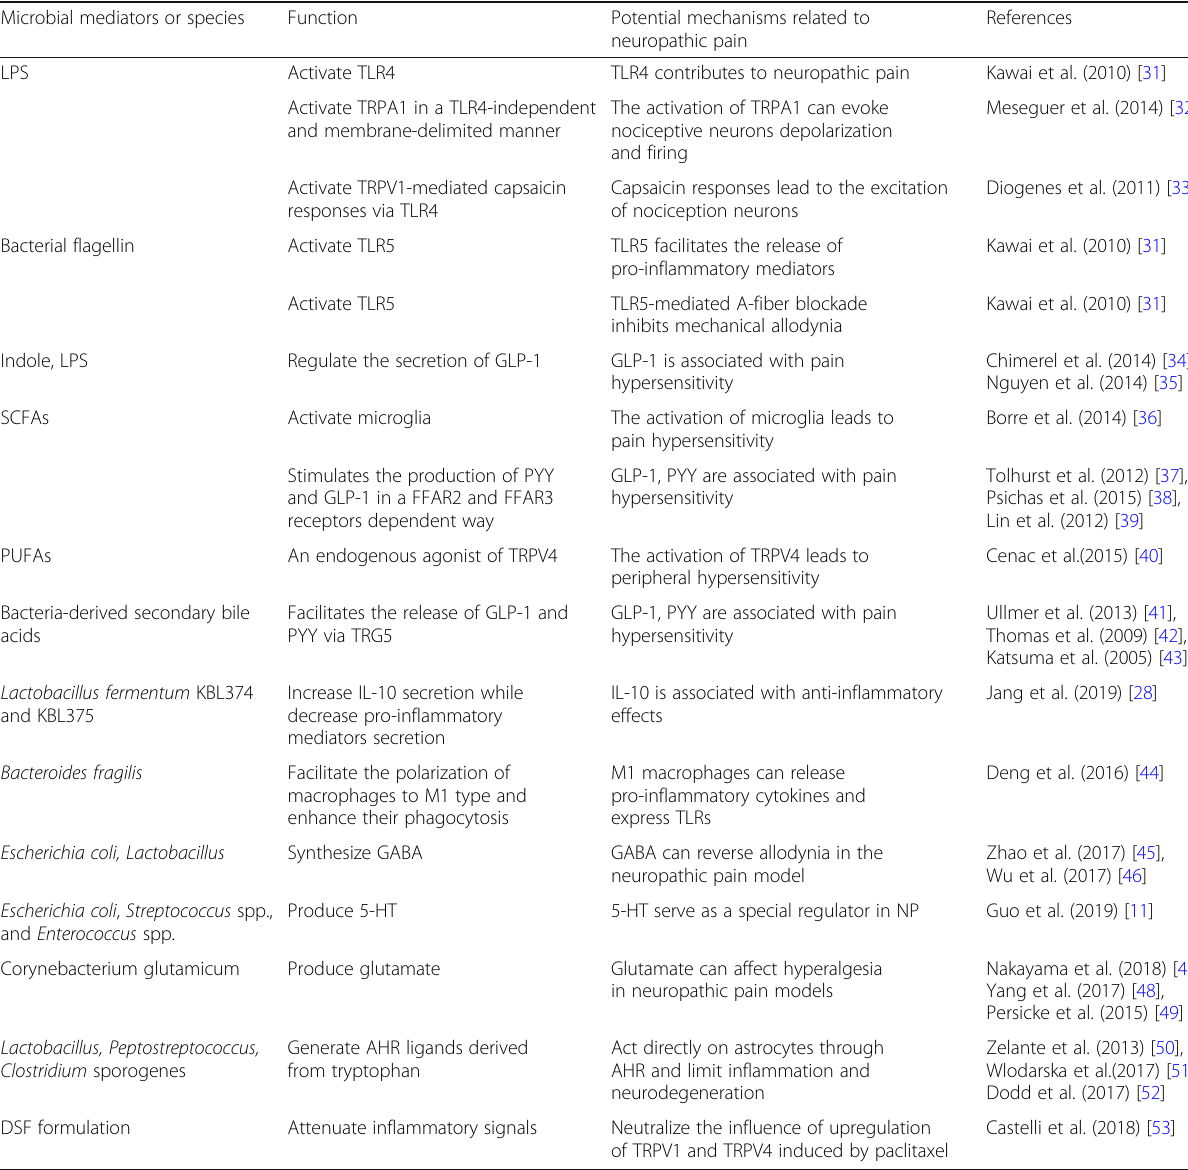
Table 1 Microbial mediators/species associated with the underlying mechanisms of neuropathic pain Microbial mediators or